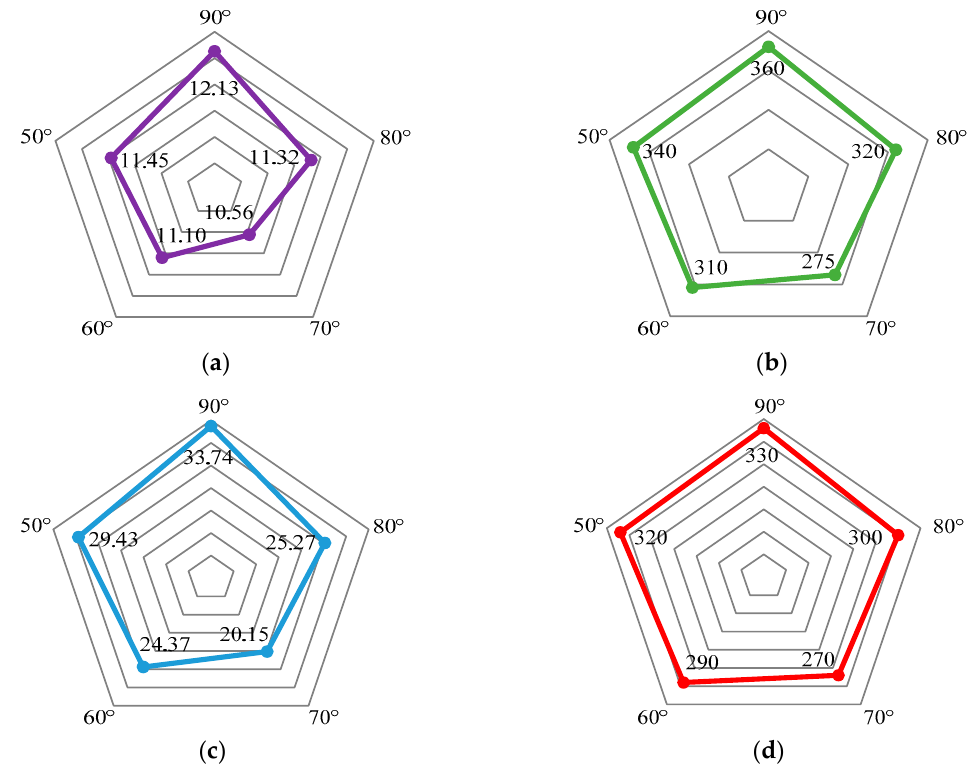
Figure 13. Numerical simulation results for different cutting angles. ( a ) Coal wall vertical stress, MPa; ( b ) Coal wall horizontal displacement, mm; ( c ) Roadside prop vertical stress, MPa; ( d ) Roadside prop vertical displacement, mm.